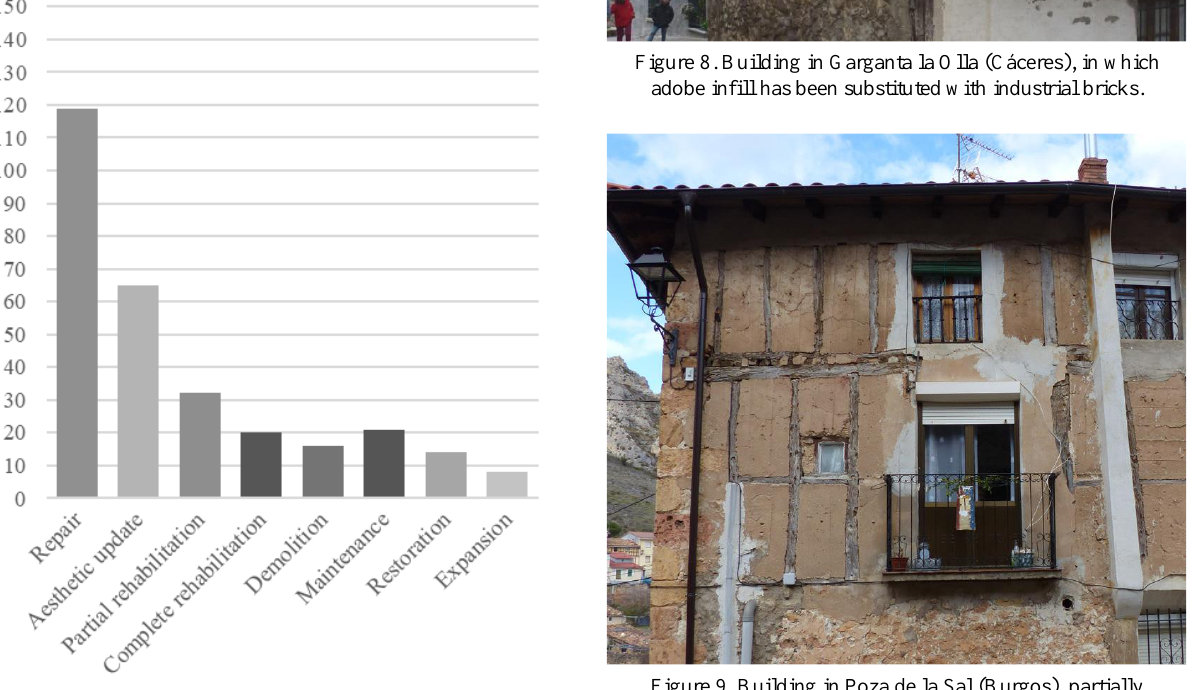
Figure 7. Type of interventions in transformed buildings.